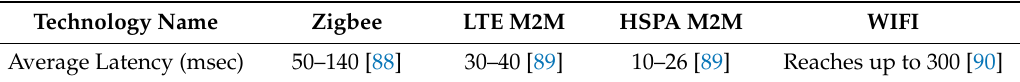
Figure 8. Variation of the DC bus voltage with different α , C T = 4800 μ F and I m = 7.1 A. Table 4. Wireless Communication Technologies’